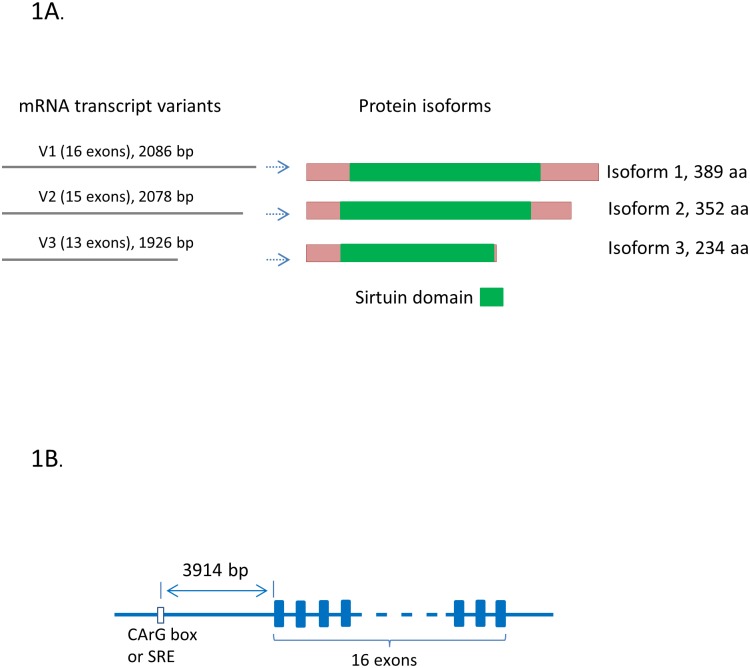
Human SIRT2 gene isoforms and the position of CArG sequence.1A. The SIRT2 gene has three mRNA transcript variants, which may translate to three protein isoforms. The main functional domain is Sirtuin domain (In green color). 1B. The classic “serum response element” (SRE or CArG) sequence is 3914 bp upstream of transcription start site.